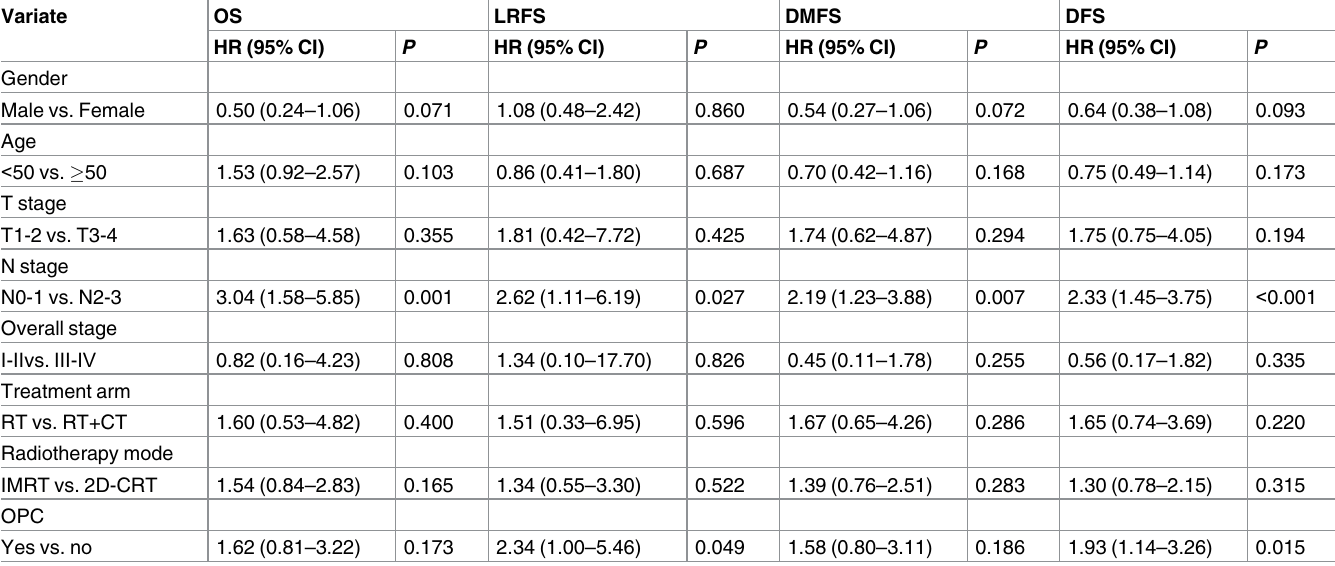
Table 7. Multivariate analysis of prognostic